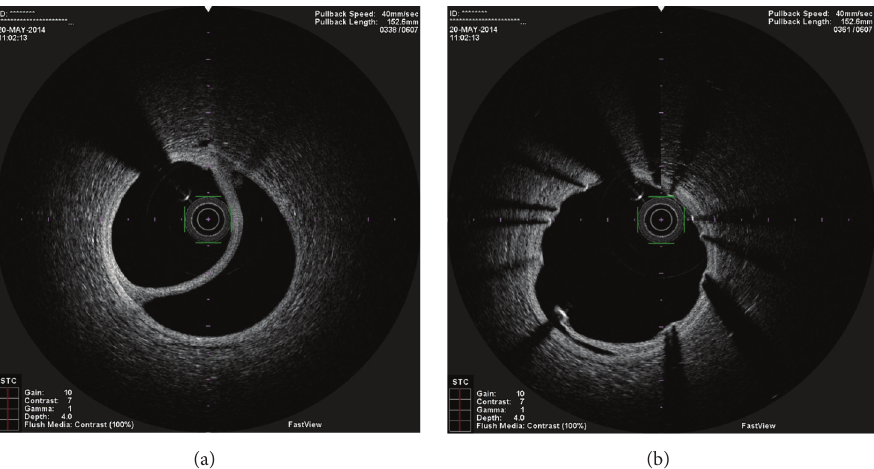
Figure 7: OCT performed one month after the stent angioplasty, showing the maintenance of the dissection. (a) shows clearly that the guide wire is in the true lumen.